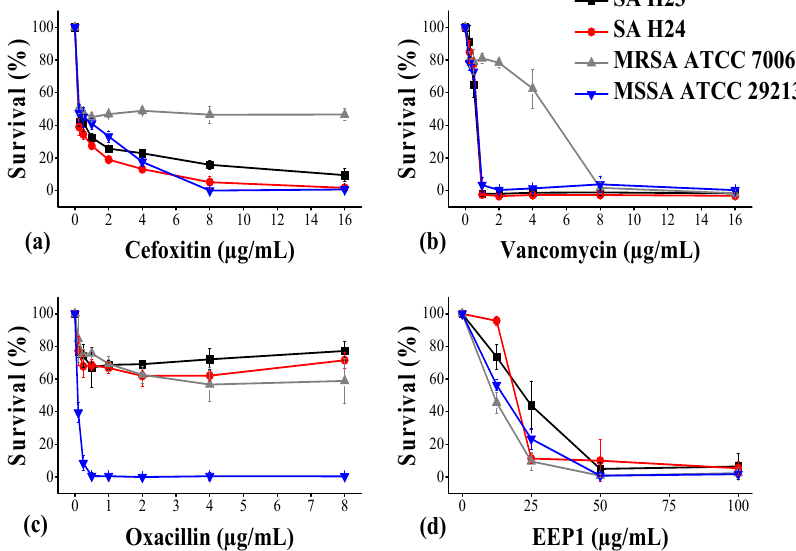
Figure 1. Inhibitory effect of antibiotic drugs: ( a ) Cefoxitin (0.25–16 µg/mL); ( b ) Vancomycin (0.25– 16 µg/mL); ( c ) Oxacillin (0.125–8 µg/mL); and ( d ) EEP1 (12.5–100 µg/mL) on S. aureus ; clinical isolates (SA H23 and SA H24), and reference strains methicillin-susceptible S. aureus ATCC 29213 (MSSA) and methicillin-resistant S. aureus ATCC 700699 (MRSA).